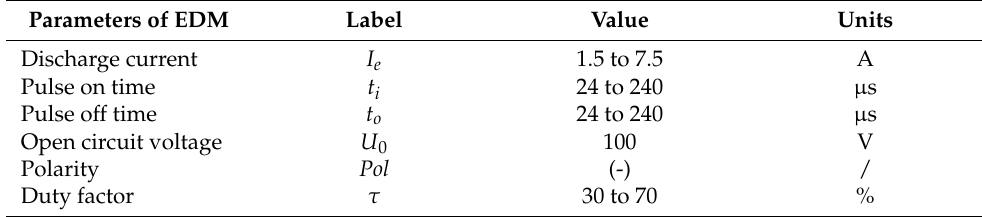
Table 1. Machining conditions.